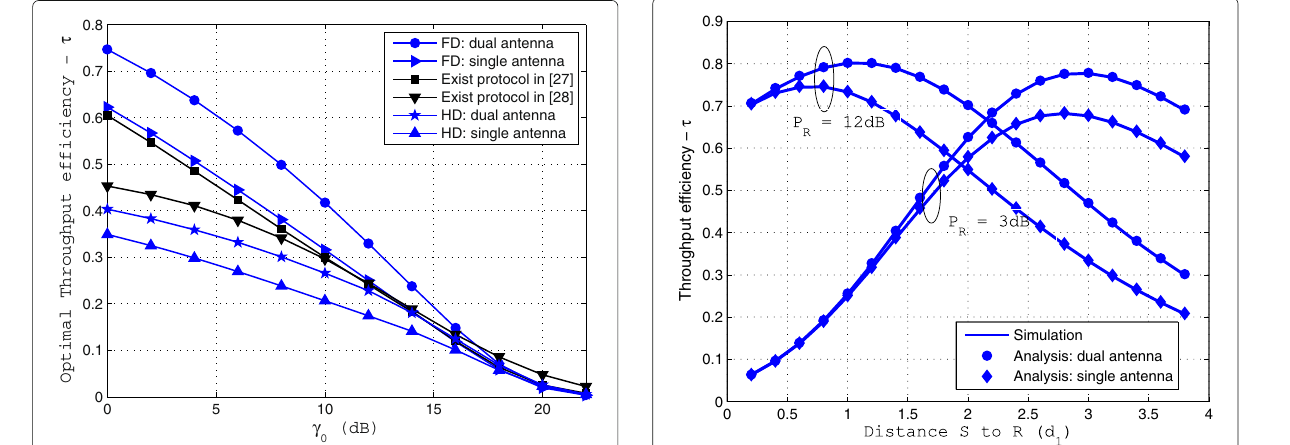
Fig. 10 Throughput efficiency versus the distance of the first hop in FD relay with m f =